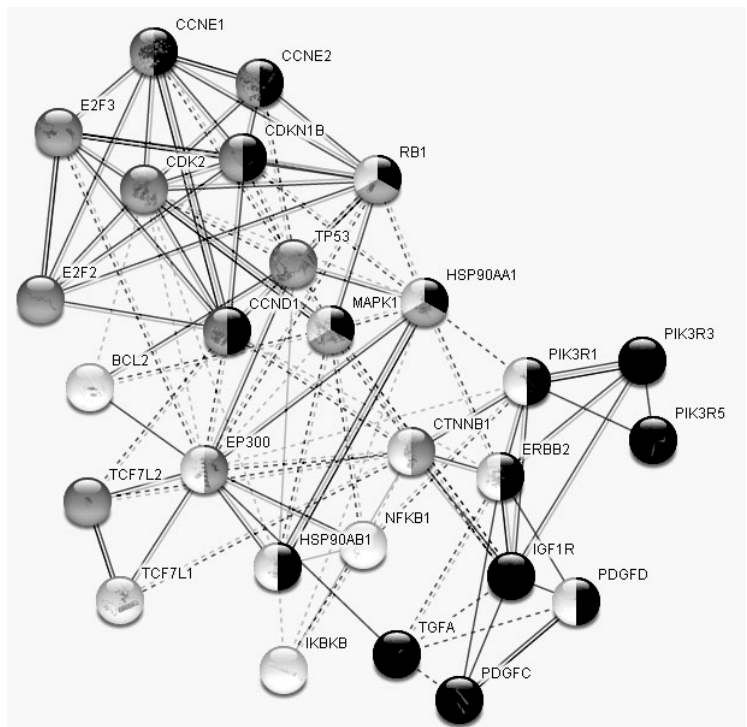
Figure 6. STRING data: Interactional network of the 27 genes responsible for “biologic regulation.” Genes involved in cell cycle regulation indicated in gray, in the regulation of the immune system process in light gray and in kinase activity regulation in dark gray.